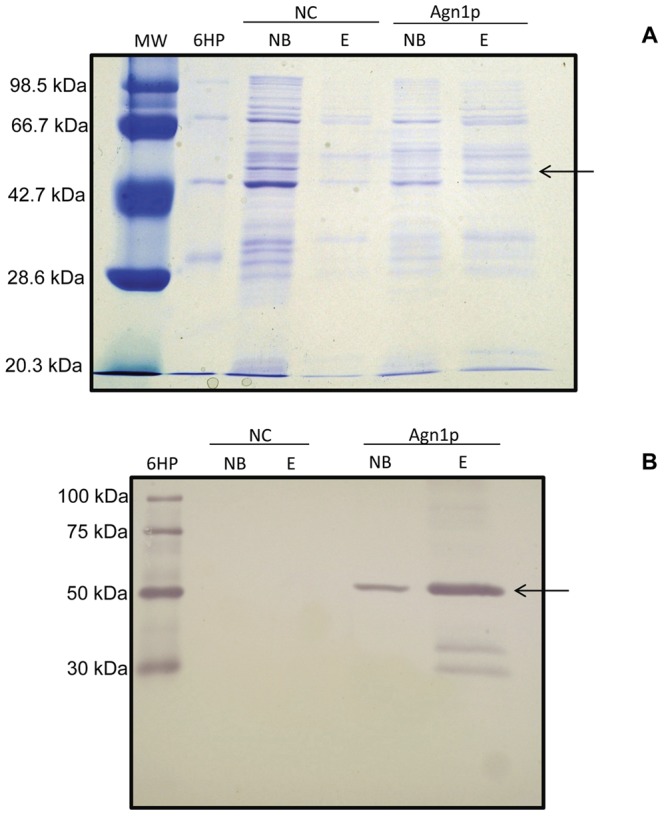
SDS-PAGE, and Western analysis of P.
brasiliensis Agn1p.Ni-NTA-purified Agn1p from cell lysates of E. coli transformed with of pQE-30Xa::AGN1 (Agn1p), and with the empty pQE-30Xa expression vector as negative control (NC) were separated by SDS-PAGE and stained with coomasie blue (A). The Ni-NTA-purified lysates were blotted on a nitrocellulose membrane and the His-tagged P. brasiliensis Agn1p (Agn1p) visualized using an anti RGS-His antibody (B). E stands for eluate, and NB for unbound material. MW: molecular weight marker. 6HP: 6xHis Ladder. Black arrow signals Agn1p position in both panels.